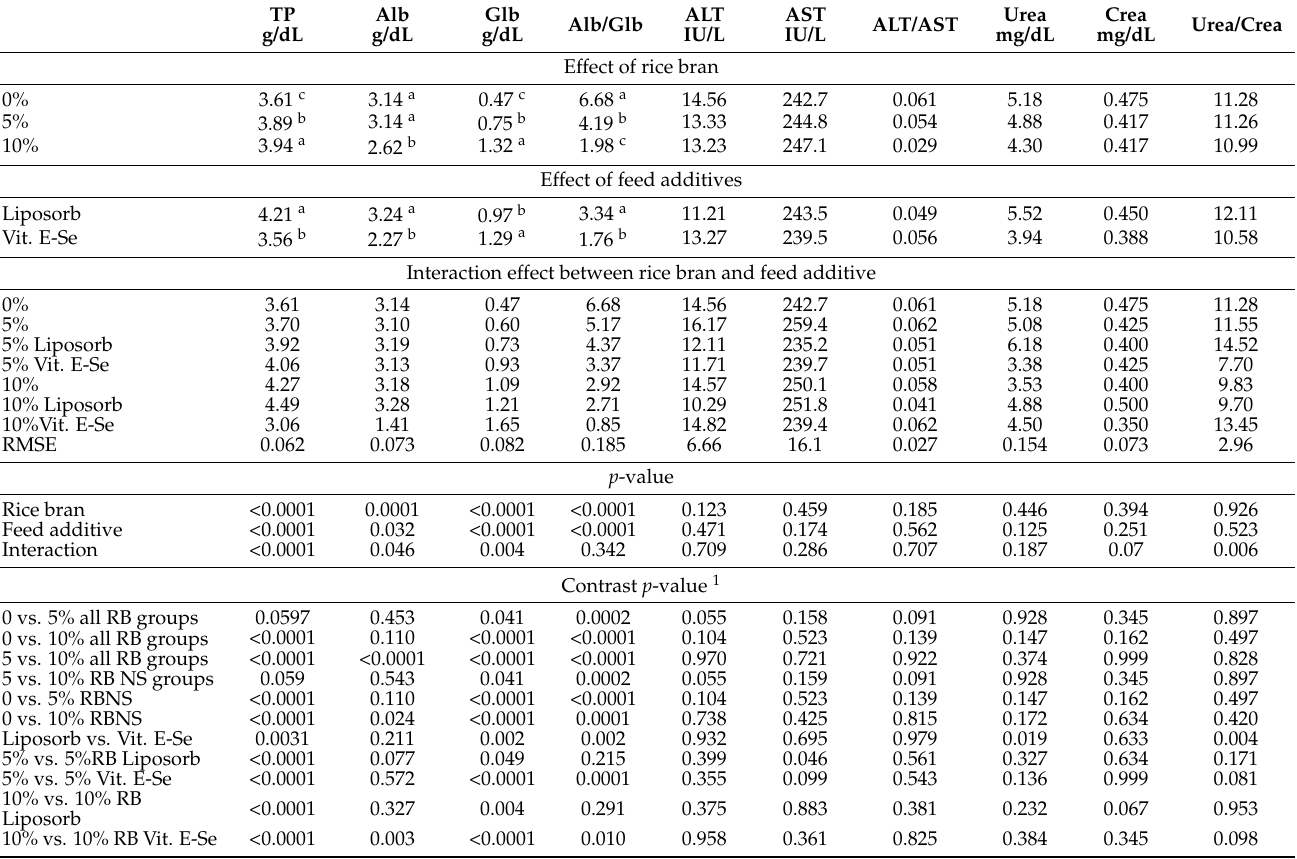
Table 5. Plasma protein components and liver and kidney functions in broiler chickens as affected by dietary rice bran treatments during the